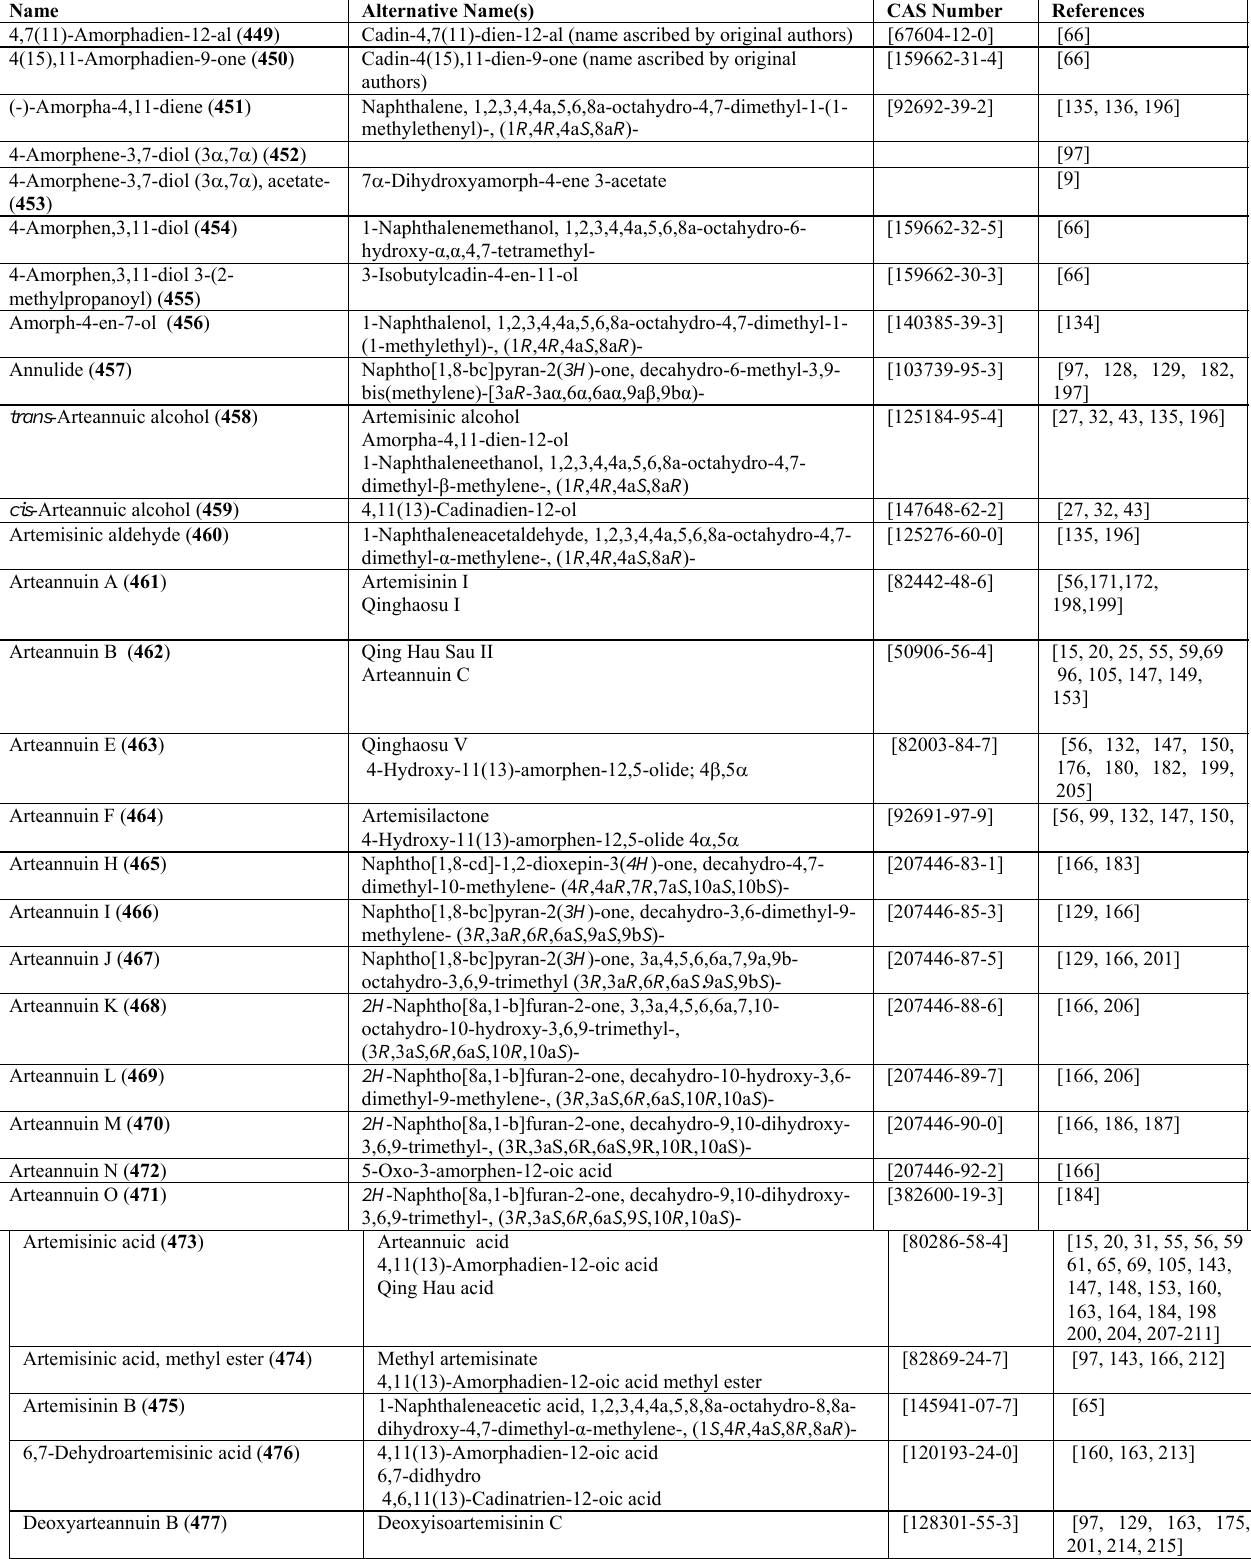
Table 36. Amorphane Sesquiterpenoids (Decahydro-1,6-dimethyl-4-(1-methylethyl)-naphthalene,